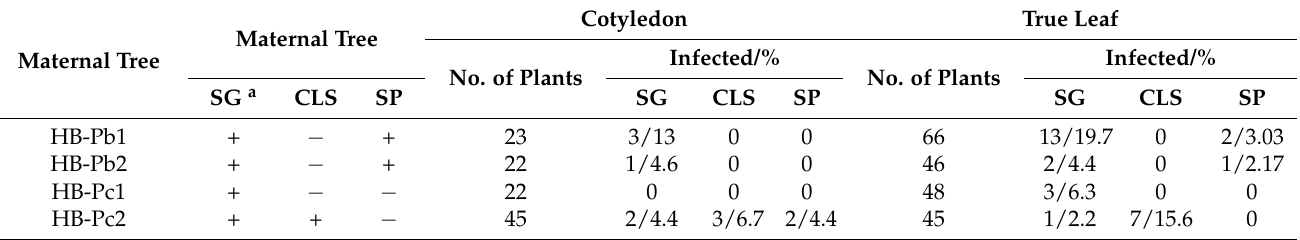
Table 4. The detection results of three viruses in seedings of P. betulaefolia and P. calleryana . Cotyledon True Leaf Maternal Tree Infected/% Maternal Tree No. of Plants No. of